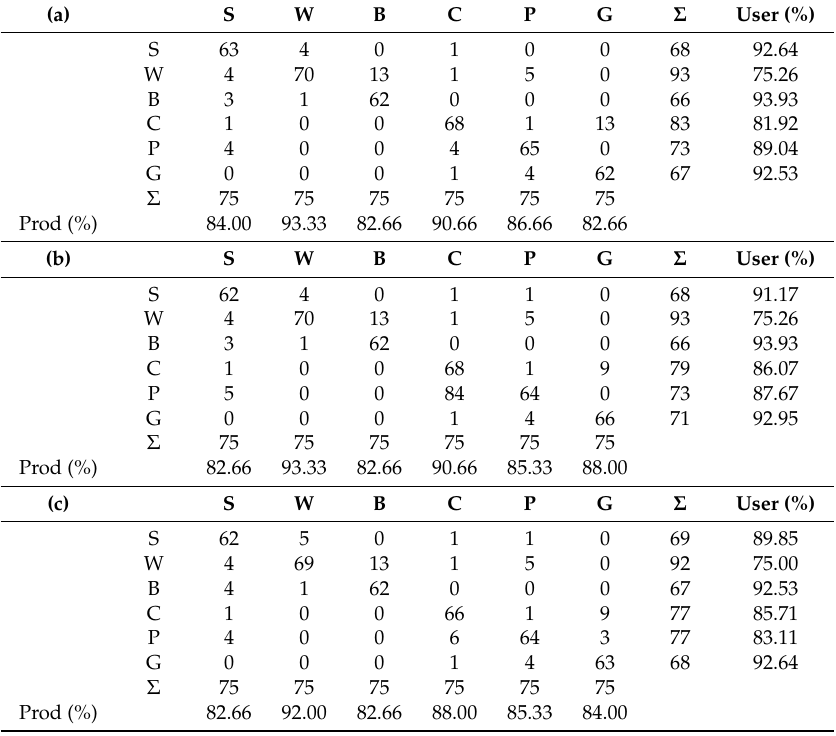
Table 11. Confusion matrices for classifications by the discriminant analysis using training sets containing cases mislabelled to a randomly selected class: ( a ) 5% error; ( b ) 10% error; and ( c ) 20% error.